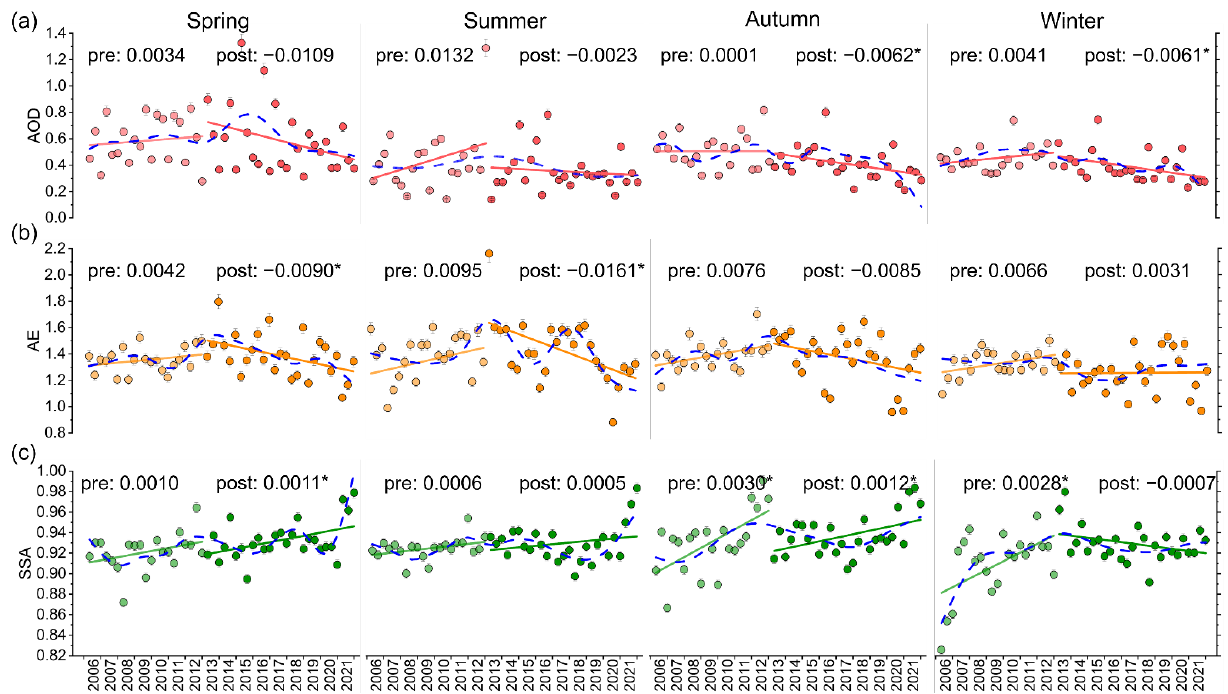
Figure 6. Linear (colored solid lines) and ESMD-based non-linear (blue dashed lines) seasonal varying trends of ( a ) AOD, ( b ) AE, and ( c ) SSA from 2006 to 2021 based on monthly averaged measurements. (* denotes the linear trends passing the 95% confidence level.)